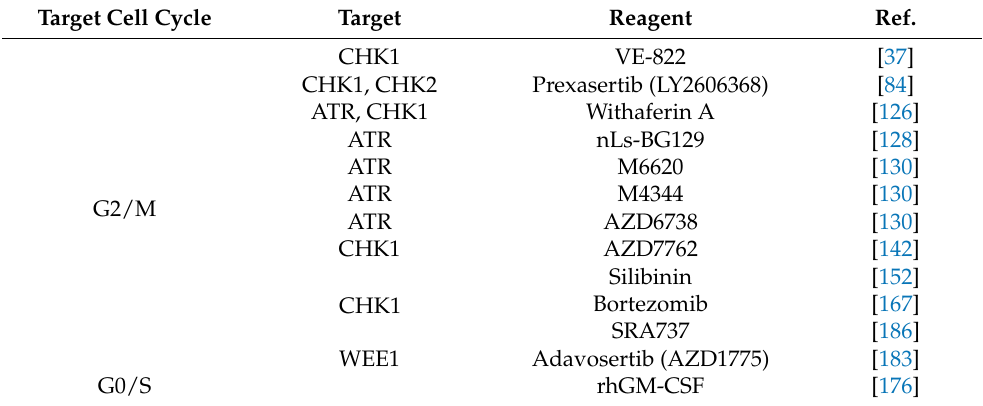
Table 1. Cell cycle targeting